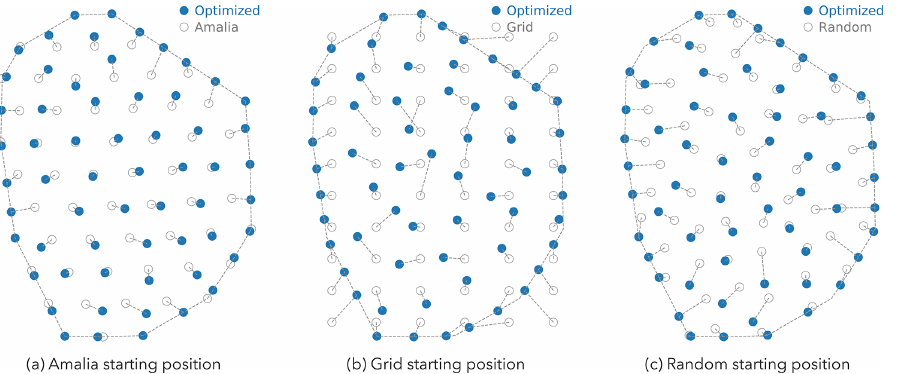
Figure 11. The initial and optimized position of the turbines for the layouts obtained with the PC-R-fine method from Fig. 10. To minimize wake losses, the turbines try to spread out as much as possible and position themselves at the boundary of the